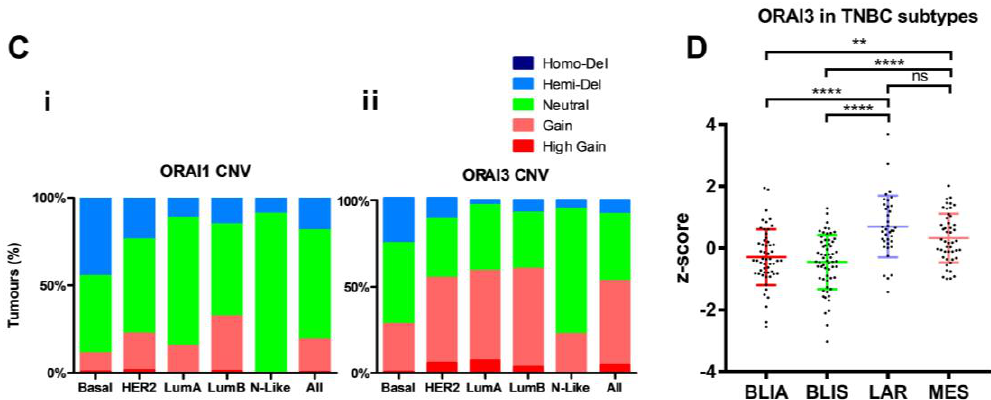
Figure 1. ORAI1 and ORAI3 are differentially expressed and amplified in breast cancer. ( A ) RNA-Seq gene expression for ORAI1, ORAI3 and commonly used molecular markers of breast cancer subtypes.